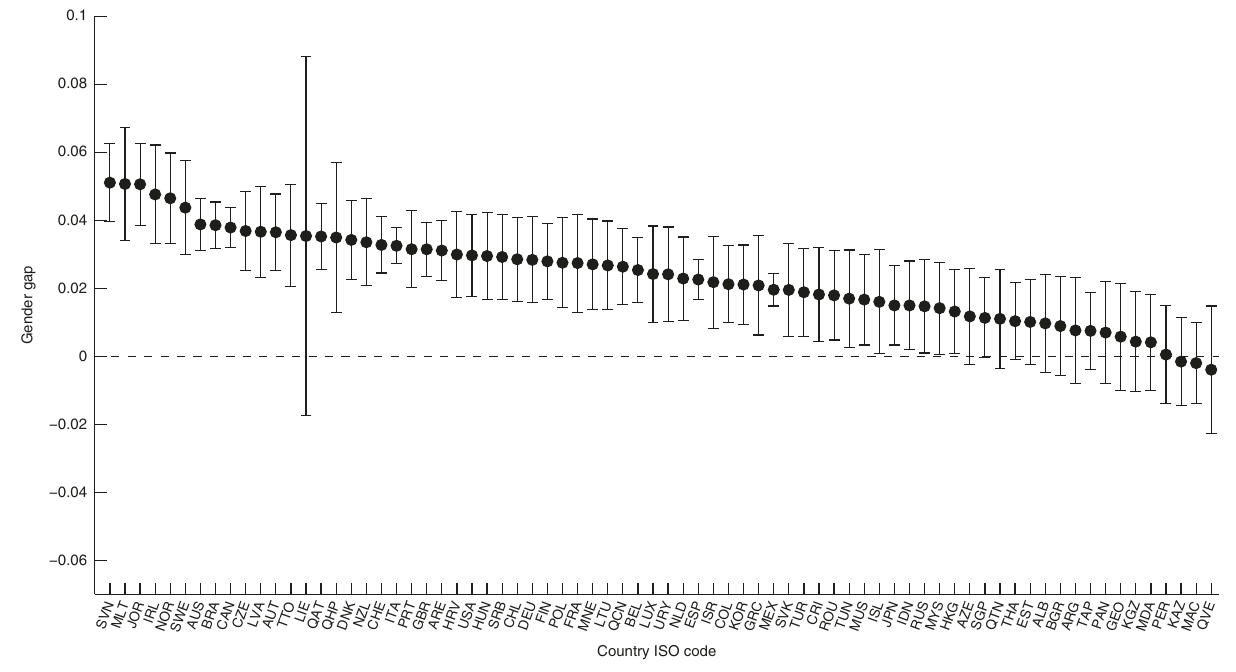
Fig. 2 Gender differences in sustaining performance. The fi gure plots the estimate of the gender difference in sustaining performance during the test for each country participating in the PISA 2009. Positive values indicate countries in which females are better able to sustain their performance during the test than males. Error bars represent the 95% con fi dence intervals. Source data are provided as a Source Data fi le (study